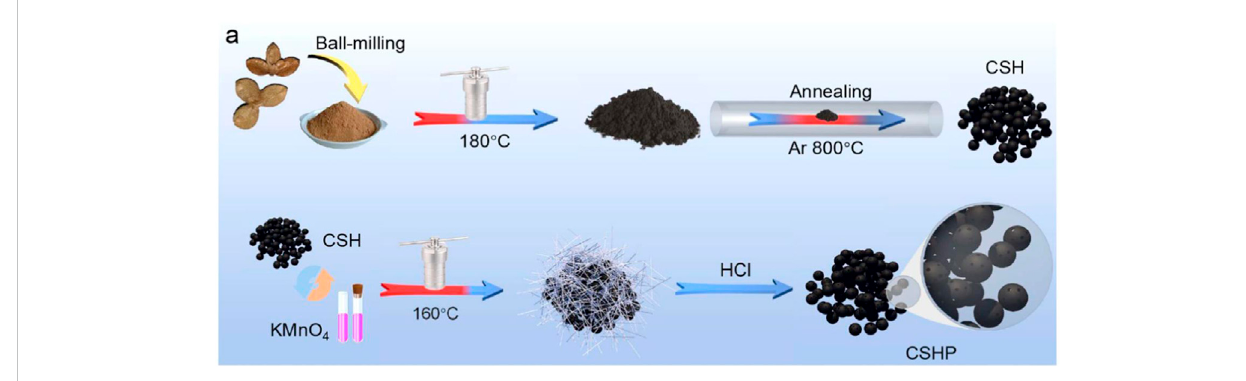
FIGURE 6 Schematic diagram of CSHP synthesis of porous carbon microspheres (Chen, et al.,